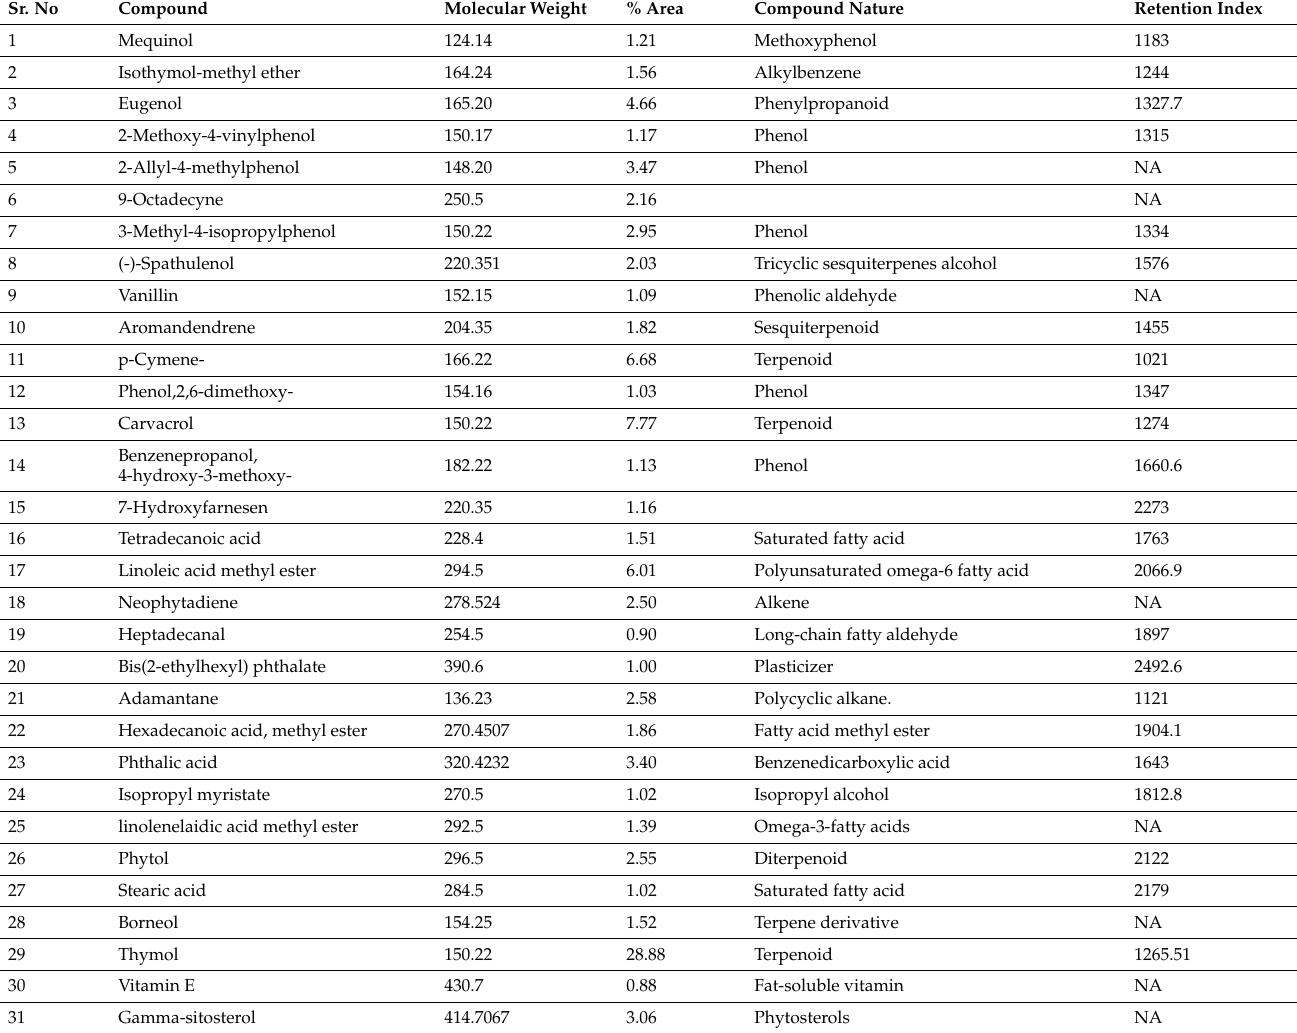
Table 1. GC-MS analysis of a methanolic extract of T. vulgaris